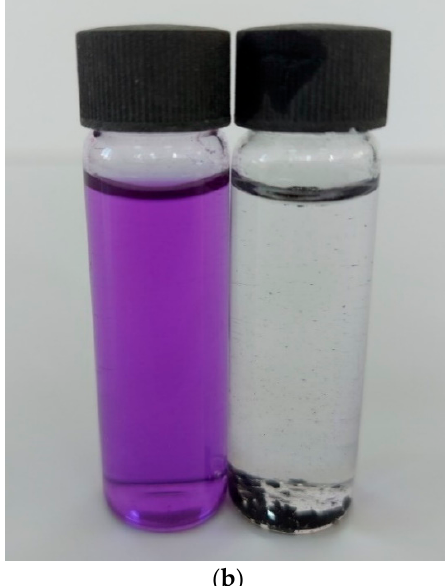
Figure 8. E ff ect of pH ( a ) and contact time ( b ) on the adsorption of M1 and M2 by the fabricated adsorbent material.